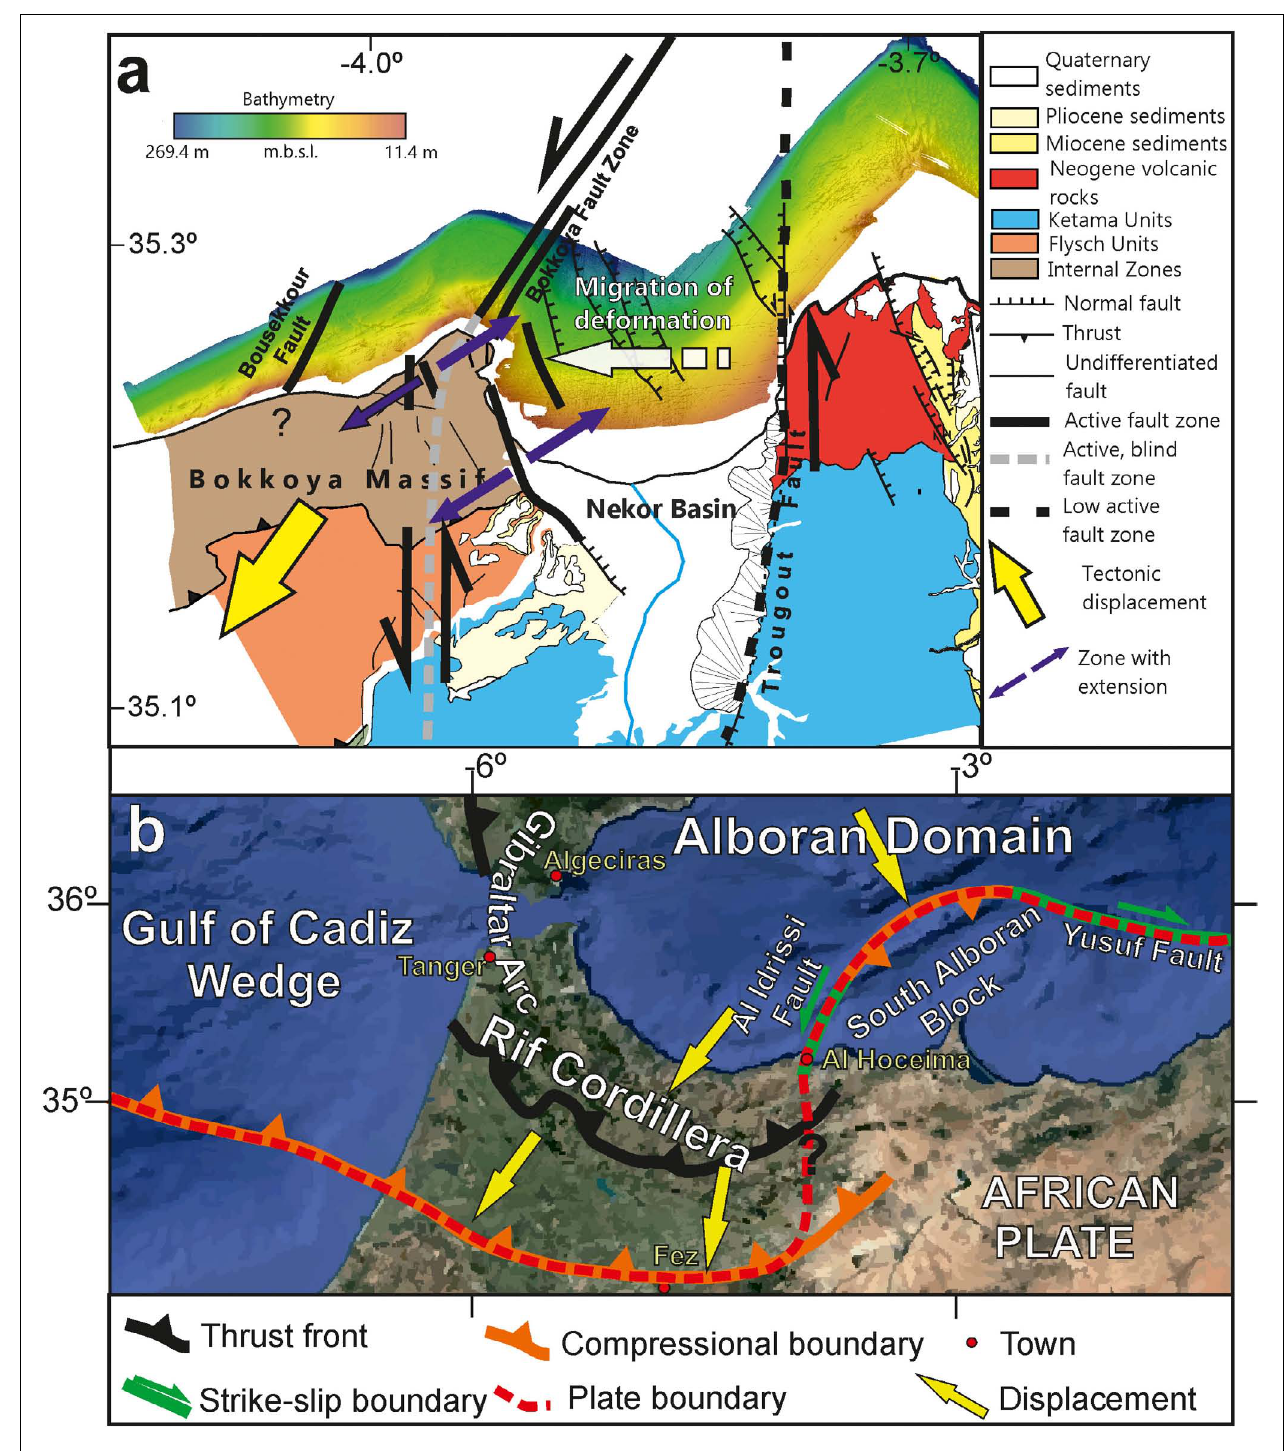
FIGURE 9 | Geodynamic sketch at the local scale (a) and regional scale (b) . Displacement directions with respect to Africa, based on Galindo-Zaldivar et al. (2018) and GPS studies (Koulali et al., 2011; Palano et al., 2015). Geological map modified from Galindo-Zaldívar et al. (2015) and swath-bathymetry of the Al Hoceima margin from Marlboro-2 Survey (d’Acremont et al.,